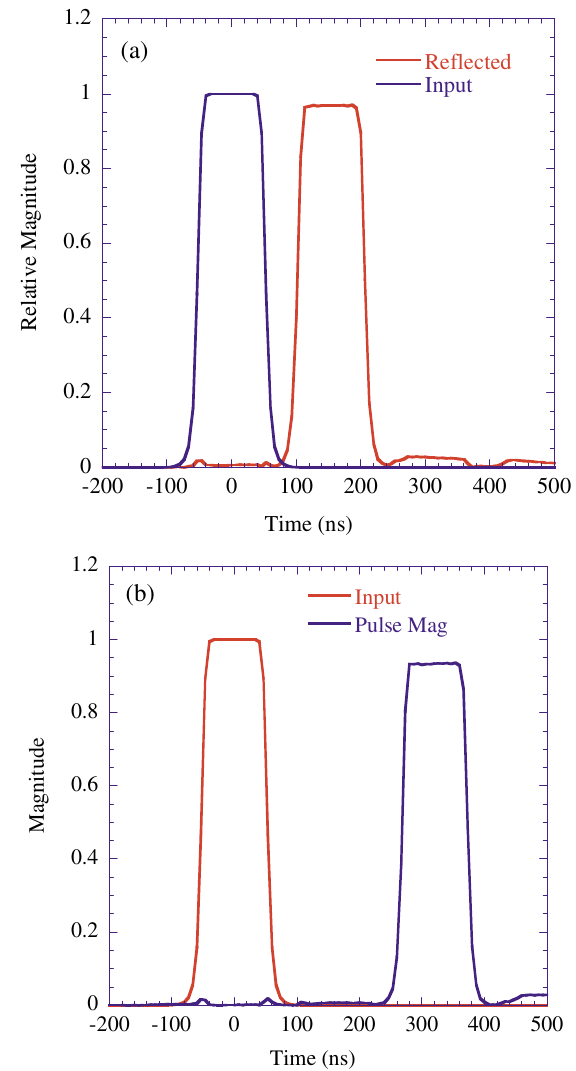
FIG. 3. (Color) (a) Measured delay through 75 ft of WC475 waveguide terminated with a flat plate. The round-trip delay time is 154 ns. (b) Measured delay through 75 ft of WC475 waveguide terminated with the TE round-trip delay time is 320 ns. The operating frequency is 11.424